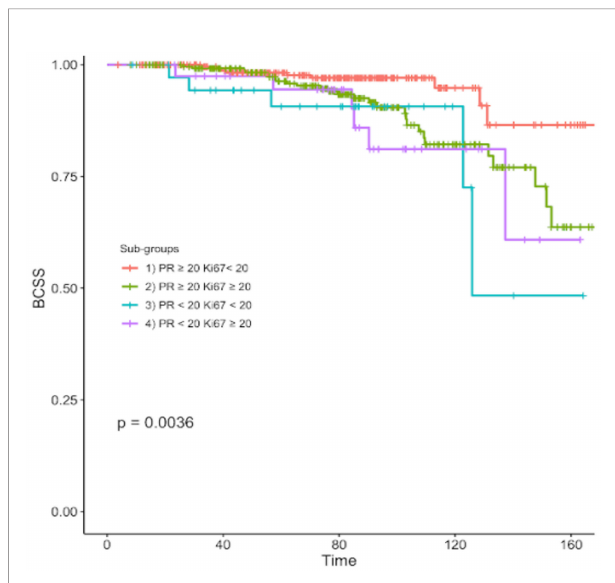
FIGURE 1 | Kaplan-Meier curve of breast cancer speci fi c survival of different subgroups according to different PR and Ki67 expression